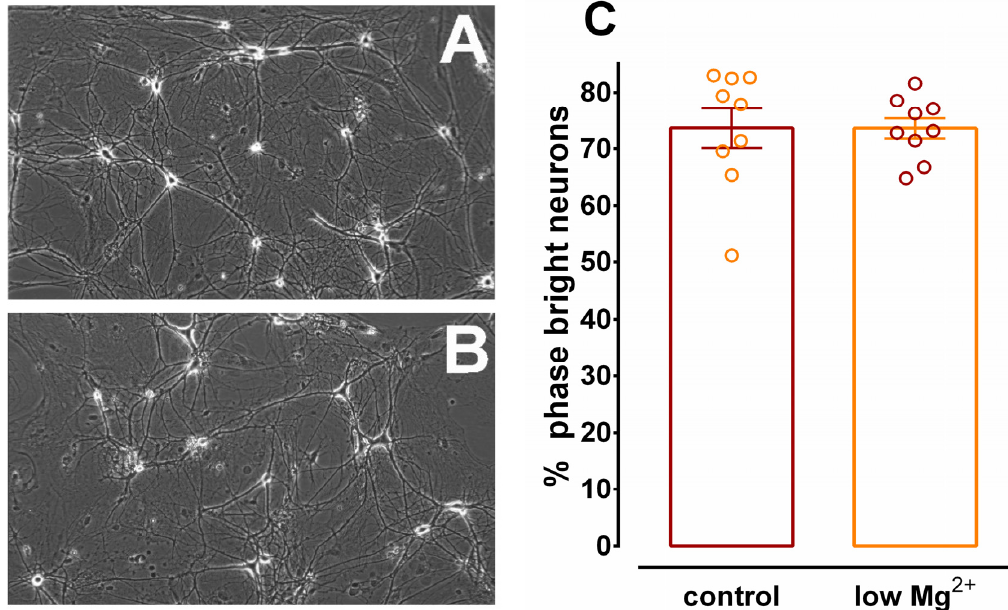
Figure 3. Viability of hippocampal neurons after 3 h of SE. Culture dishes were incubated in control or low Mg 2 + solutions and assessed for viability by a blind observer as described in Materials and Methods. Representative phase contrast images of cultures exposed for 3 h to either control ( A ) or low Mg 2 + ( B ) solutions. Images are presented at a 20 × magnification. Quantification of neurons ( C ) using the criteria of phase bright (viable) and phase dark (non-viable). The number of phase-bright cells was divided by the total number of cells (phase bright + dark). Two-tailed unpaired t -test revealed that there was no significant difference in neuronal viability between the two treatment groups ( p = 0.99, n = 9 dishes each with multiple fields analyzed per dish).